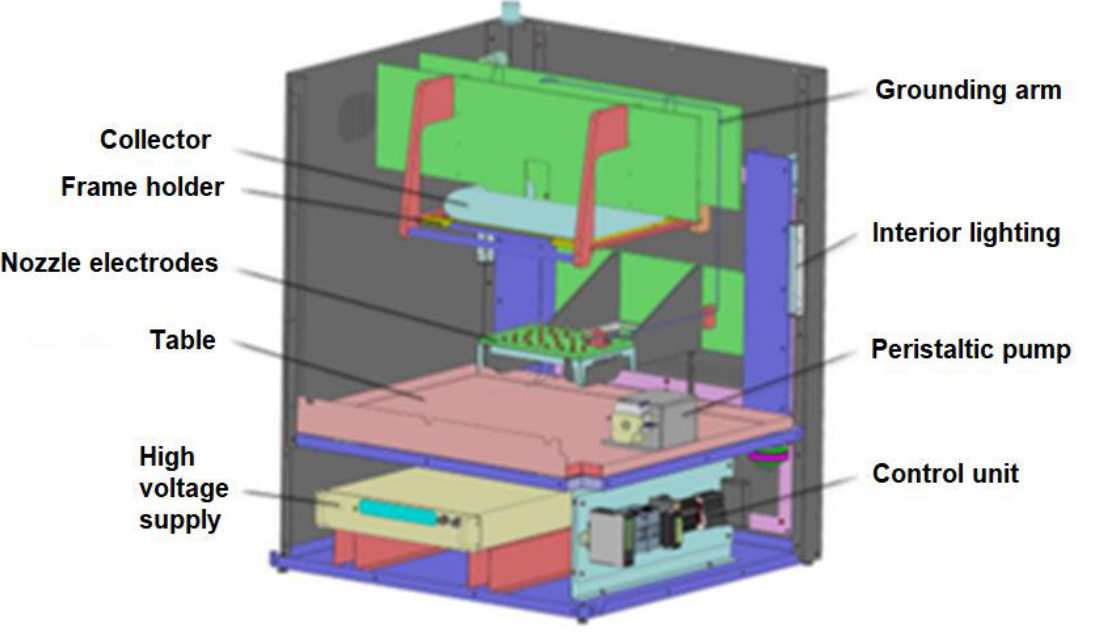
Figure 1. Setup of the electrospinning instrument used.